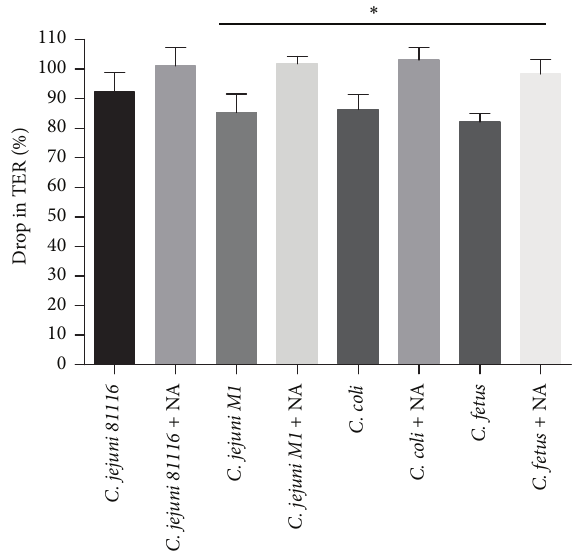
Figure 4: The effect of noradrenaline on the tight junction integrity of T84 epithelial cells was measured by percentage drop in transep- ithelial resistance (TER) at 48 hours after infection with Campy- lobacter species. Results are the mean of three separate experiments, and bars represent standard error. Star indicates 𝑃 < 0.05 . A significantly higher drop in TER was noticed when noradrenaline was added to the transwells infected with C. jejuni M1 , C. coli, and C. fetus fetus